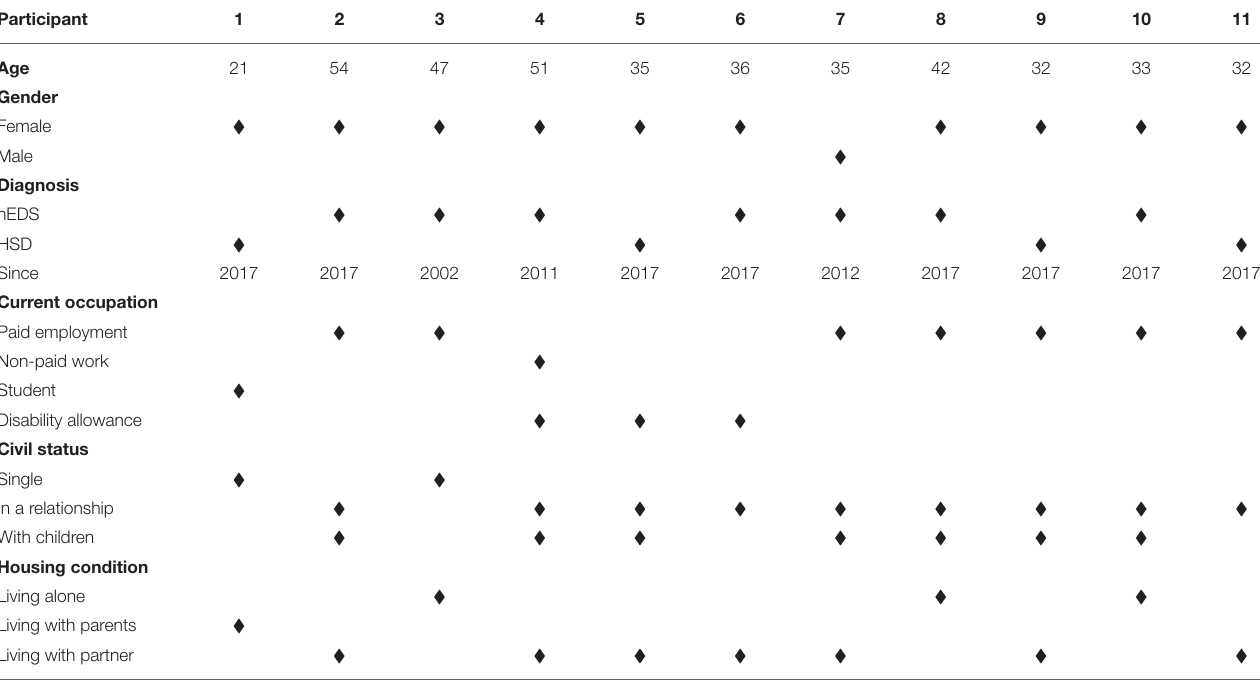
TABLE 2 | Sample characteristics ( n = 11).